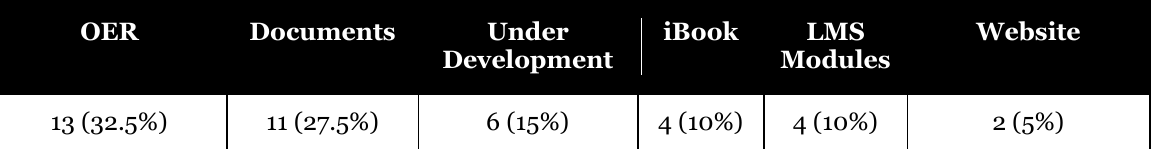
Number (Percentage) of OAER